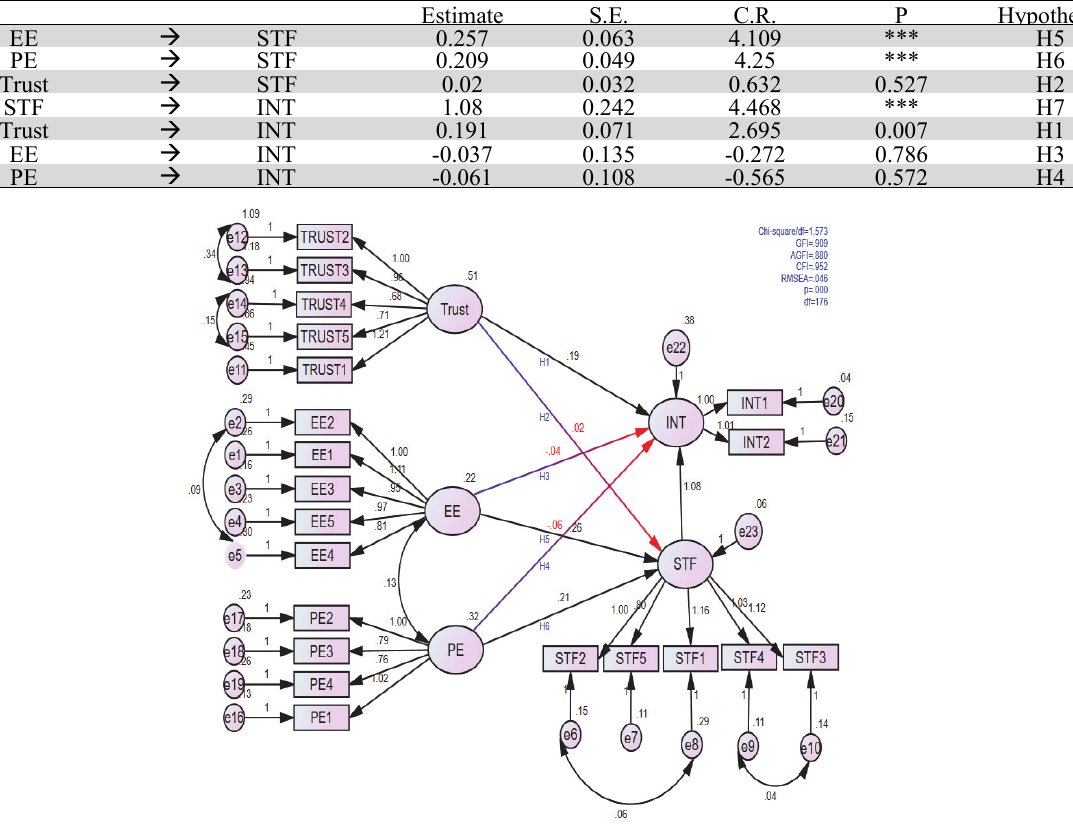
Regression Weights: (Group number 1 - Default